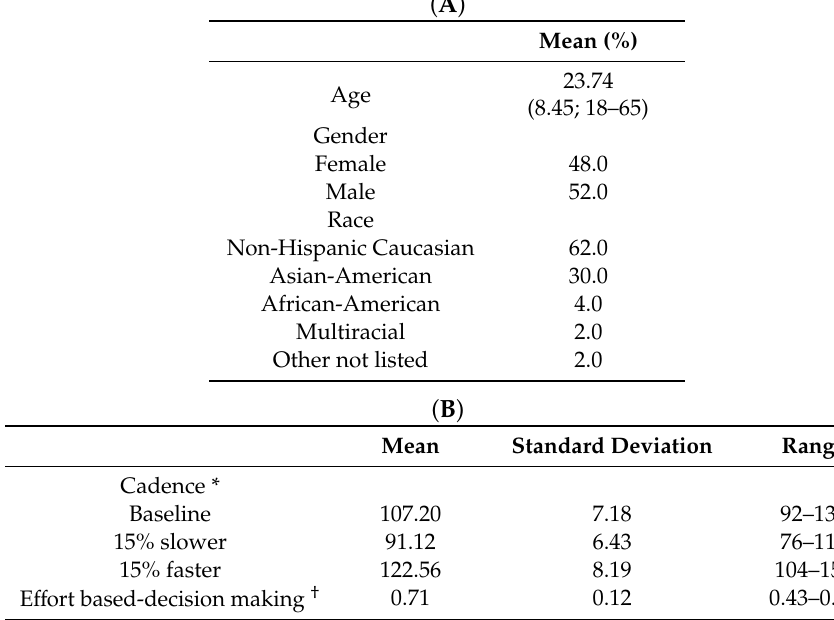
Table 1. ( A ) Descriptive statistics of demographic information ( N = 50). The standard deviation and range (respectively) are included in parentheses below the mean age. ( B ) Descriptive statistics of Cadence and E ff ort-based decision making ( N =